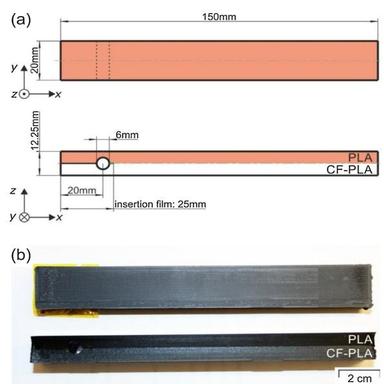
Double cantilever beam test specimen dimensions (a) and two 3Dprinted specimens (b). The z -coordinate of the coordinate system presented in (a) is the direction, in which the layers are deposited upon each other.